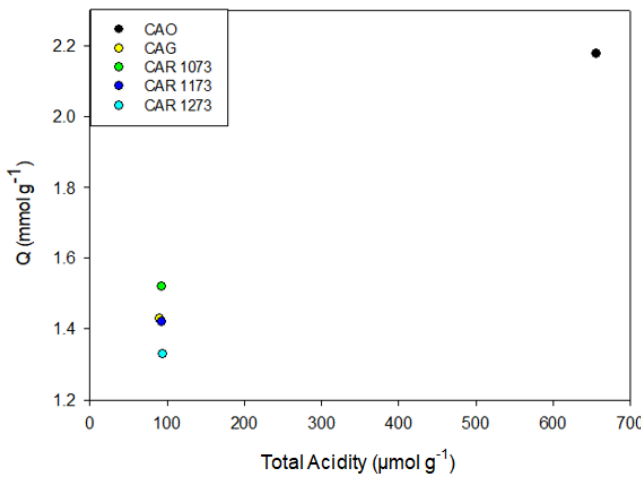
Figure 11. Relation between the adsorption capacity and total acidity on the adsorption of methylparaben on the activated carbons CAO, CAG, CAR1073, CAR1173, and CAR1273.